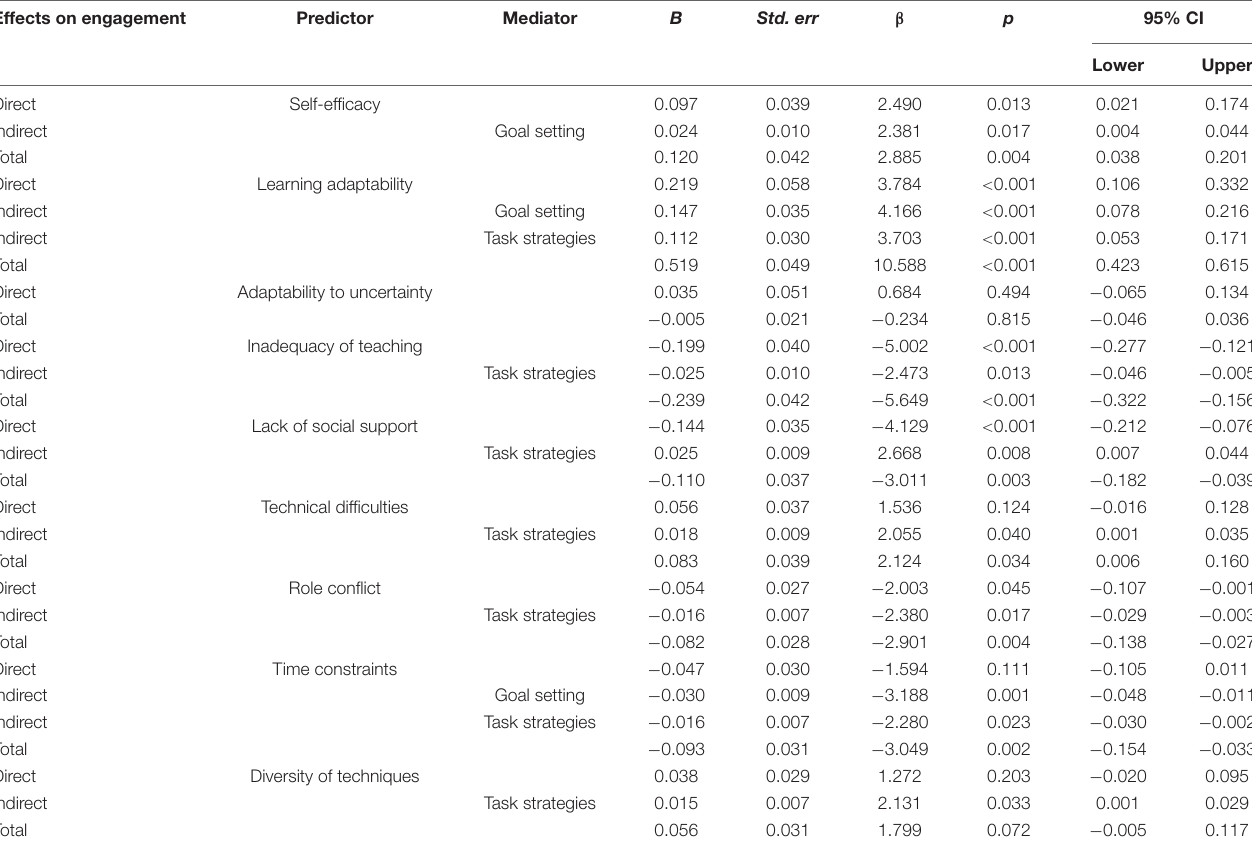
TABLE 2 | Direct, indirect and total effects (significant) for the mediating effect of the self-regulated learning. Effects on